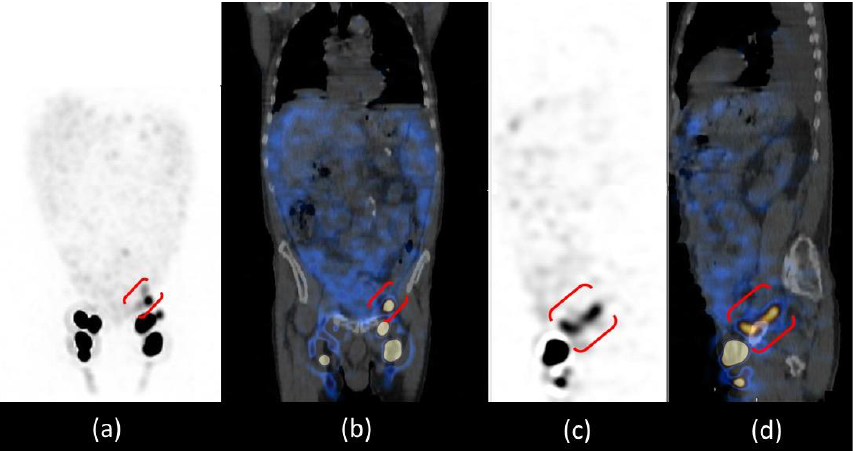
Figure 4. SPET/CT whole body lymphoscintigraphy: MIP ( a ), coronal fused image ( b ), sagittal SPET ( c ) and fused images ( d ). All images confirmed the presence of inguinal lymph nodes and the focal spot of radiotracer uptake in the left iliac region, which in sagittal images is better evidenced as a “ whisker ” due to the dilatation of the lymphatic pathway at the site of the surgical interruption (red brackets).